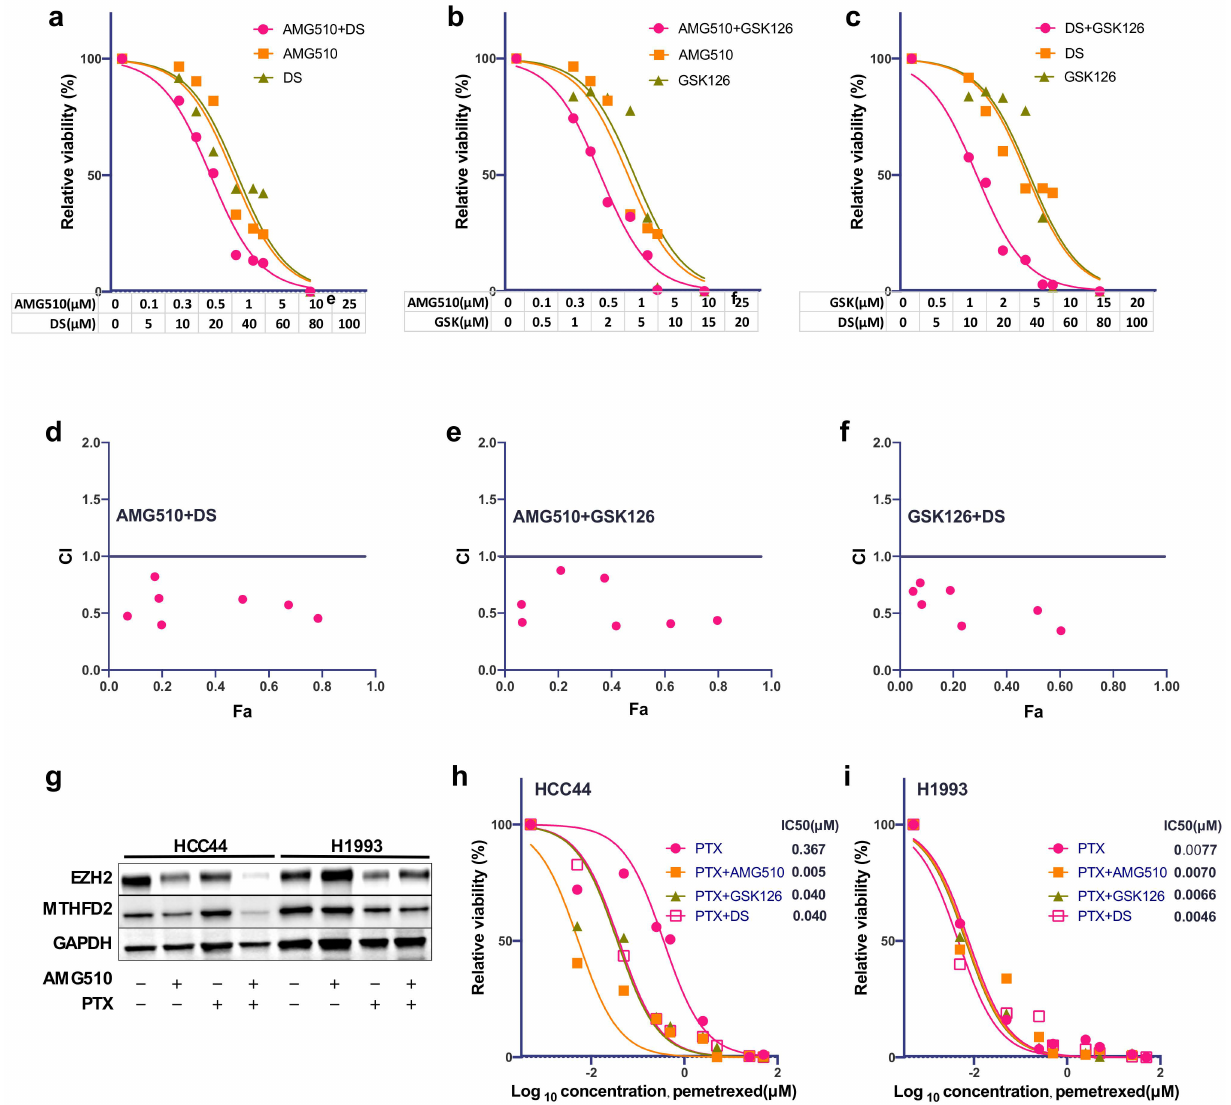
Figure 4. Combinational treatment of KRAS G12C cells with EZH2 and MTHFD2 inhibitors. ( a ) Cellular survival of HCC44 after treatment with AMG510, DS, or the combined treatment at indicated concentrations for 72 h. ( b ) Cellular survival of HCC44 after treatment with AMG510, GSK126, or the combined treatment at indicated concentrations for 72 h. ( c ) Cellular survival of HCC44 after treatment with DS, GSK126, or the combined treatment at indicated dosages for 72h. ( d – f ) Combination index (CI) plot for AMG510, DS, and GSK126 in HCC44. CI values are plotted as a function of the fractional inhibition of cell viability by computer simulation using CompuSyn; the pink dots represent the actual experimental points. CI values: synergism (CI < 0.9), additive effect (CI = 0.9–1.1), and antagonism (CI > 1.1). ( g ) Western blot analysis of EZH2 and MTHFD2 ex- pression of HCC44 and H1993 after 48 h single treatment with AMG510 (2 µ M) or PTX (20 µ M) or in combination. ( h , i ) Dose–response curve of HCC44 and H1993 after 72 H single treatment with PTX (0.005–50 µ M) alone or in combination with AMG510 (2 µ M), GSK126 (2.5 µ M), or DS (10 µ M),